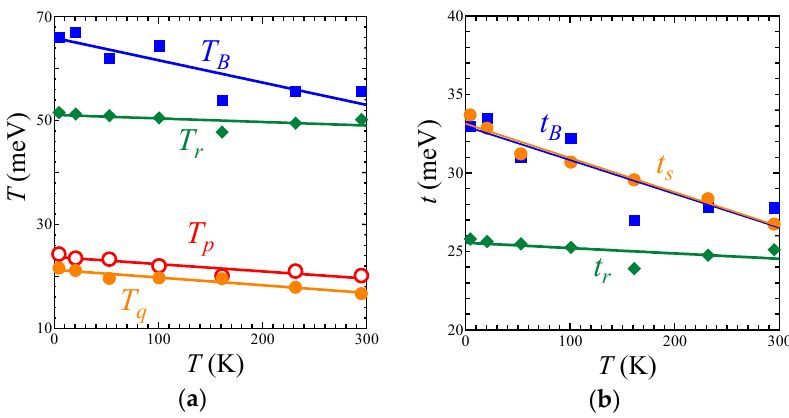
Figure 2. Temperature dependence of ( a ) intermolecular transfer integrals, T B , T r , T p , and T q and ( b ) interdimer transfer integrals, t B , t s , and t r , in the EtMe 3 Sb salt.